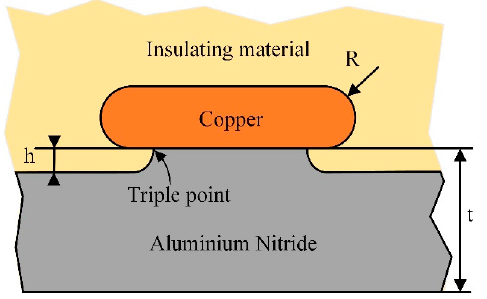
Figure 6. Protruding structure. Materials 2020 , 13 , x FOR PEER REVIEW